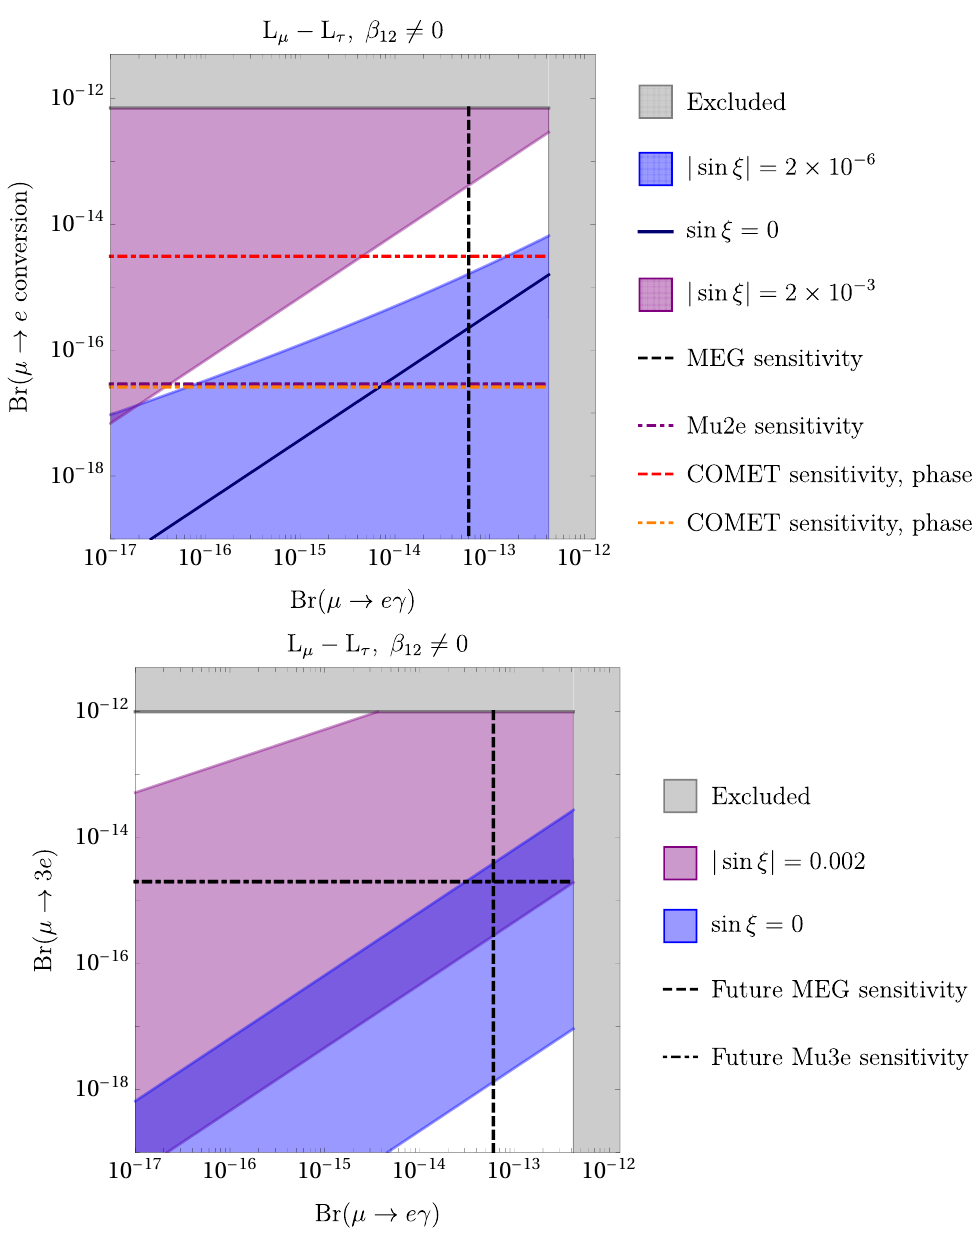
Figure 12. Correlations between different µ → e transitions in the L µ − L τ scenario with left- handed 1–2 rotations ( β = 0 12 6